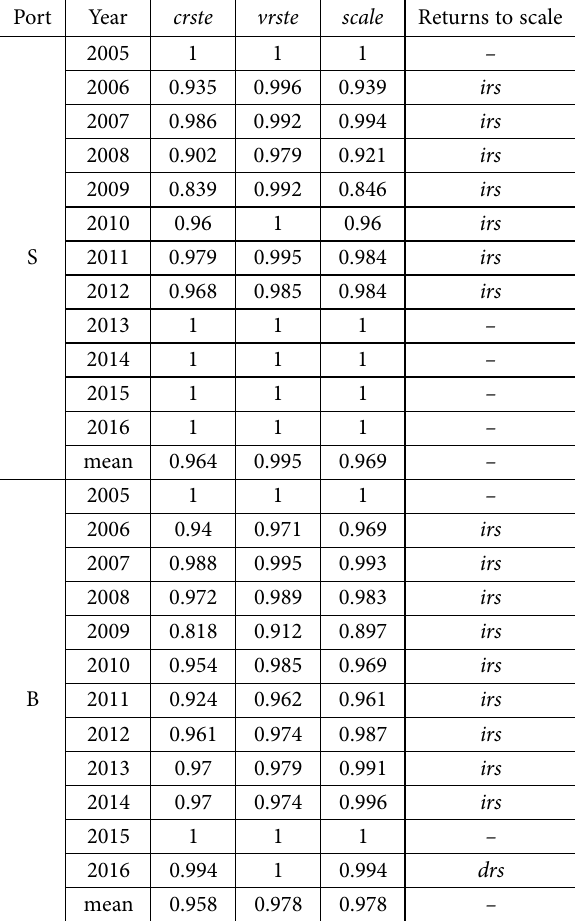
Table 4. Results of the third